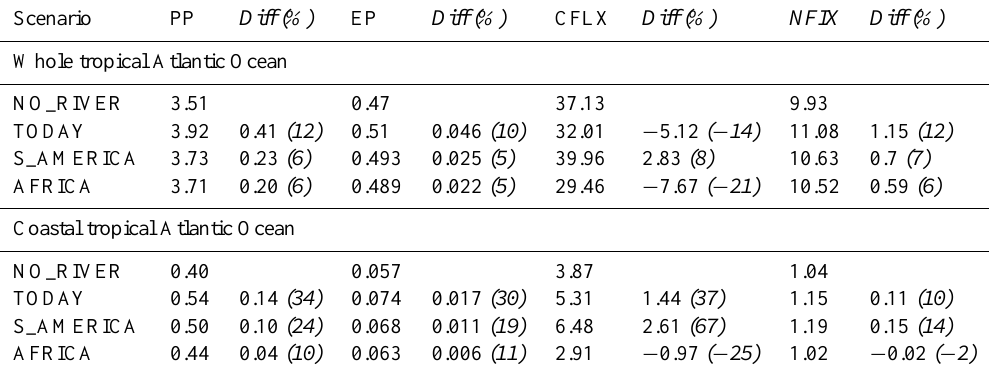
Table 3. Primary production (PP) and export production (EP) in PgCa − 1 , sea-to-air CO 2 fluxes (CFLX) in TgCa − 1 , and N 2 -fixation (NFIX) rates in TgNa − 1 , for each scenario considering the whole and coastal tropical Atlantic Ocean (20 ◦ S–20 ◦ N, 70 ◦ W–20 ◦ E). The columns in italics correspond to the difference (“Diff”, in PgCa − 1 or TgCa − 1 ) between the TODAY, S_AMERICA, AFRICA scenarios and the NO_RIVER scenario. The numbers in parenthesis correspond to the change in % relative to the NO_RIVER scenario ((((scenario –